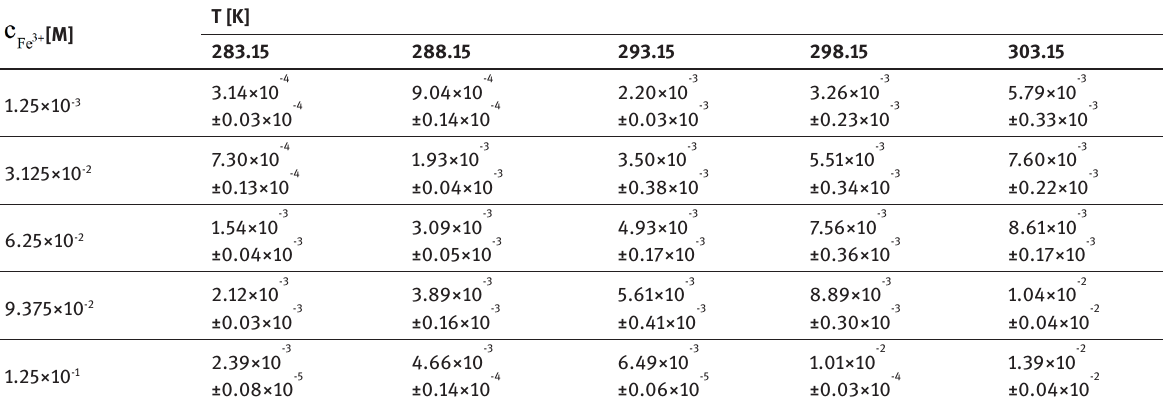
Table 2 : The values of the spontaneous reaction rate k (s -1 ) and the apparent second-order rate constant k of [Co(ODA)(H O) ] at five temperatures studied. The concentration of 2 3 [Co(ODA)(H O) ] equals 4×10 -3 M, [H 2 3 NO 3- ) = 1.0